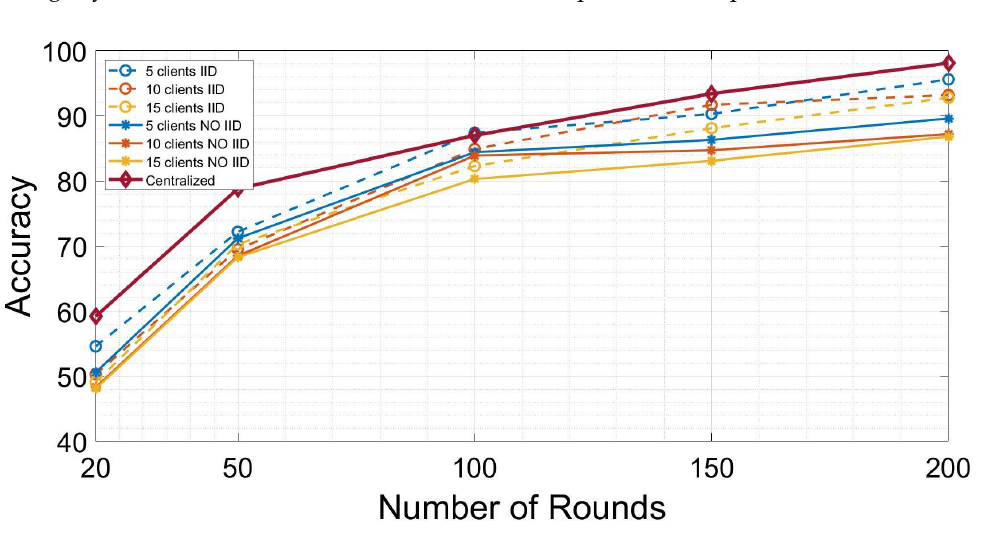
Figure 5. Accuracy comparison between the IID, NO IID, and centralized IID